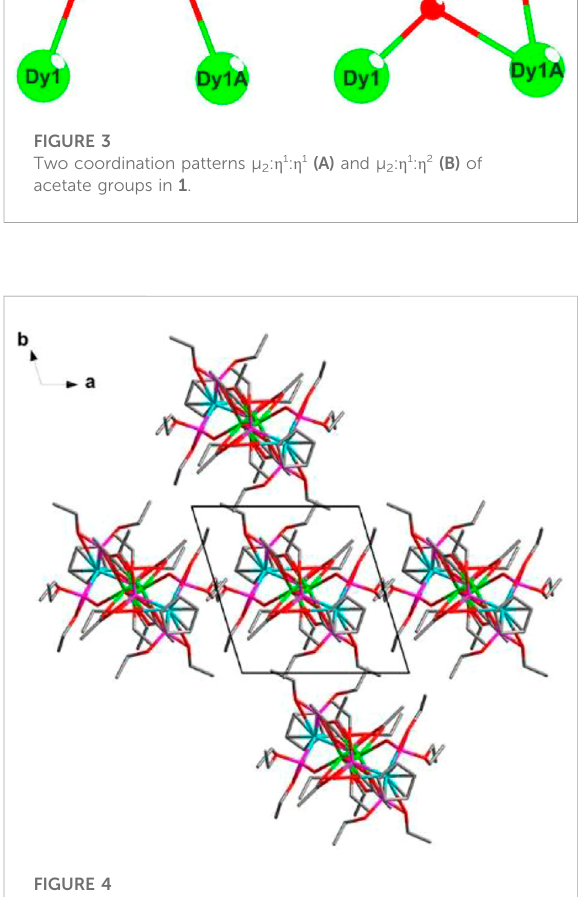
FIGURE 4 Molecular structure packing diagram along the c- axis of 1 .